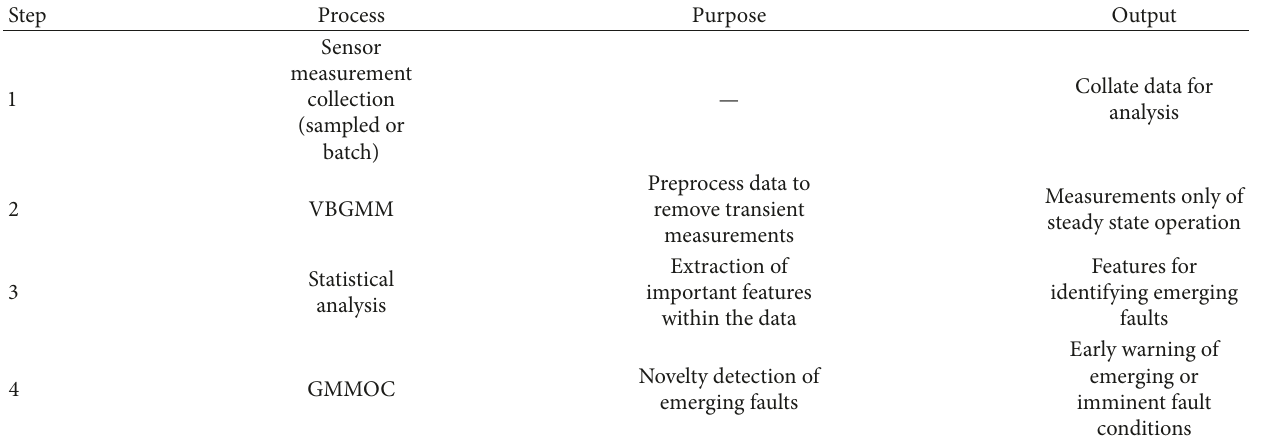
Table 1: Stages of the proposed